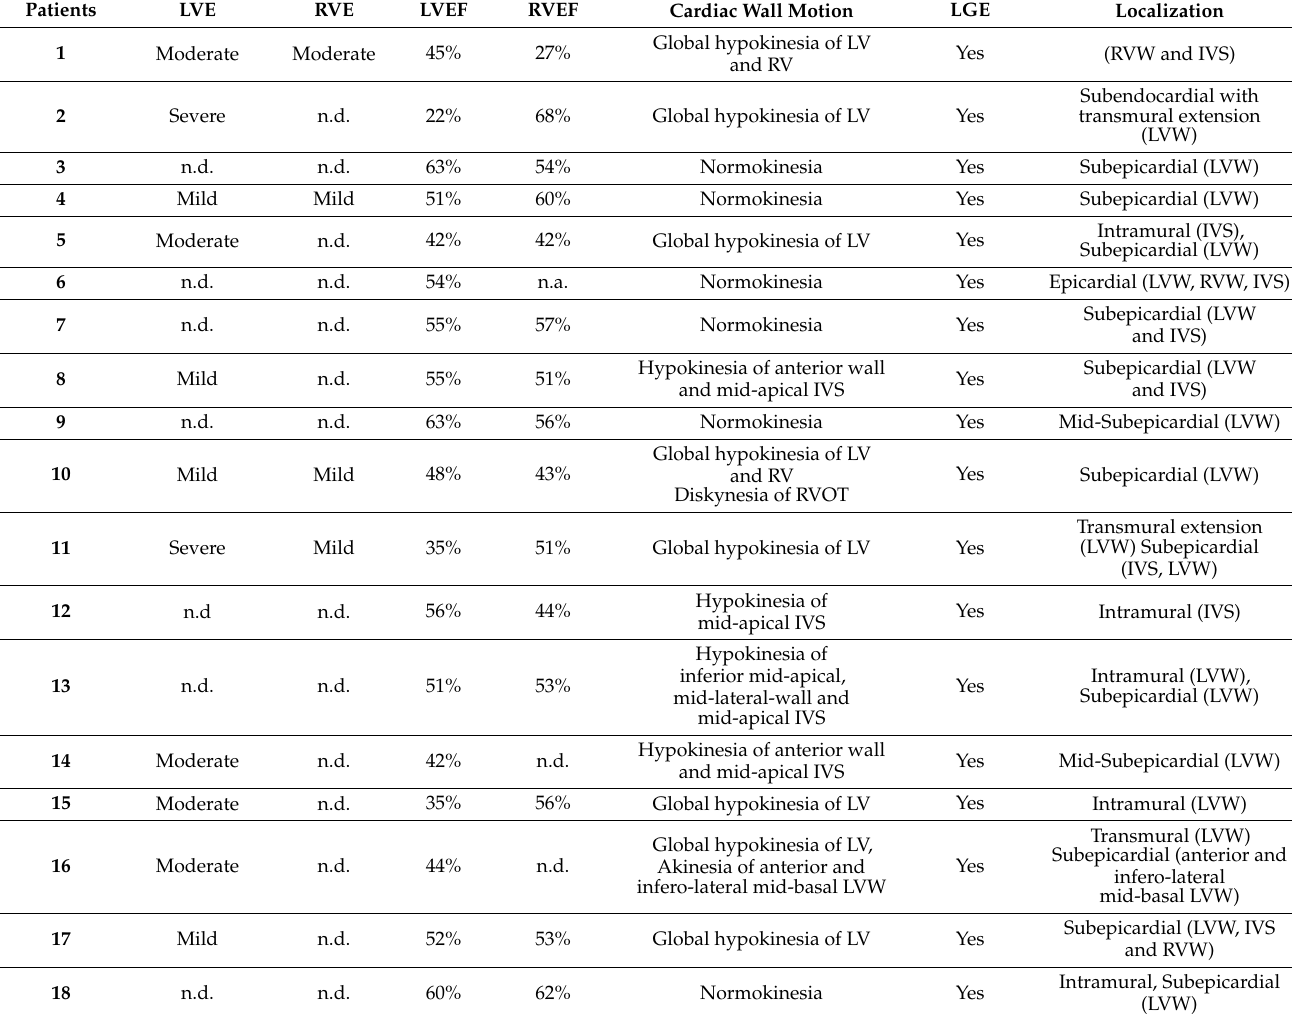
Table 3. Cardiac imaging of probands at first clinical